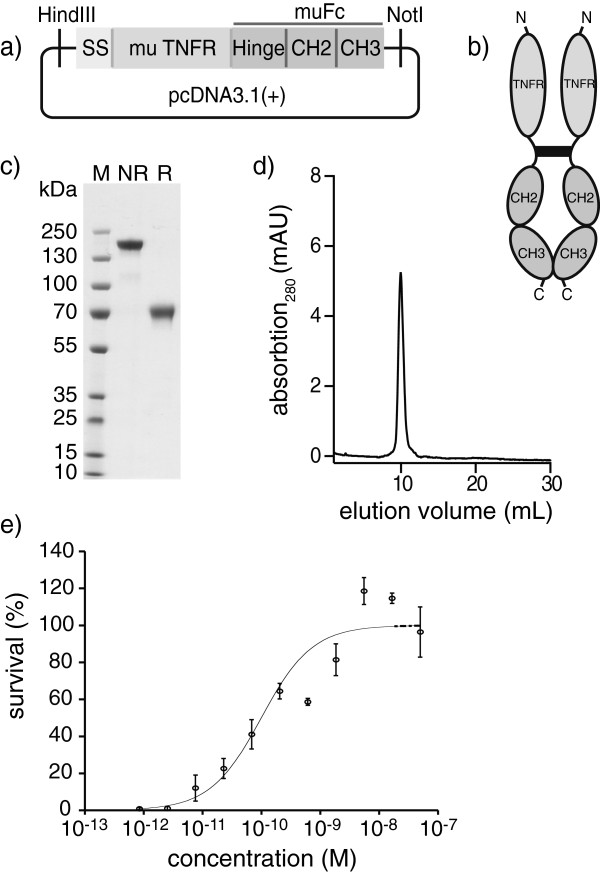
Cloning, expression and in vitro characterization of muTNFR-Fc. (a) Schematic representation of the cloning strategy of muTNFR-Fc. muTNFR was directly fused to the Fc fragment (hinge, CH2 and CH3 regions) of murine IgG1, containing a signal sequence (SS) for secretion of the protein at the N-terminus. (b) Schematic representation of the formation of a muTNFR-Fc dimer trough disulfide bridges in the hinge region. (c) SDS-PAGE analysis of purified muTNFR-Fc. M, molecular weight marker; NR, nonreducing conditions; R, reducing conditions. (d) Size exclusion chromatography (SEC200) of covalent homodimeric muTNFR-Fc. (e) Bioactivity assay of muTNFR-Fc. muTNFR-Fc inhibited tumor necrosis factor (TNF)-induced killing of mouse fibroblasts with a half-maximal inhibitory concentration of 0.1 nM (mean ± standard deviation, n = 3).